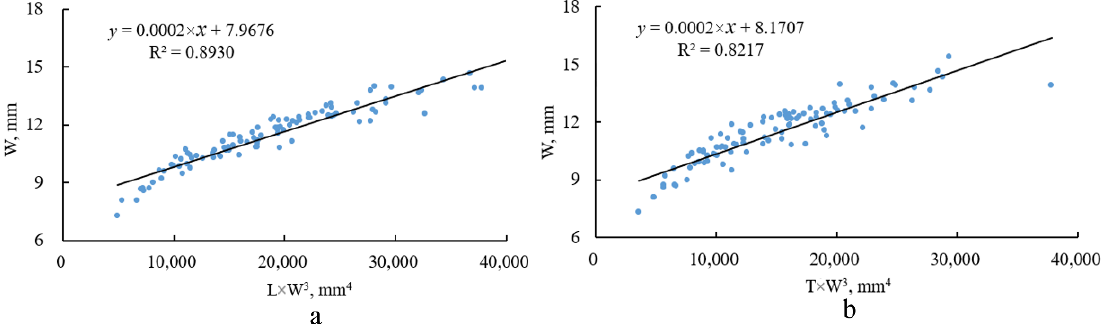
Figure 6. Relationships between two dimensions of Jinong 2 seeds: ( a ) width–length and ( b ) width–thickness.